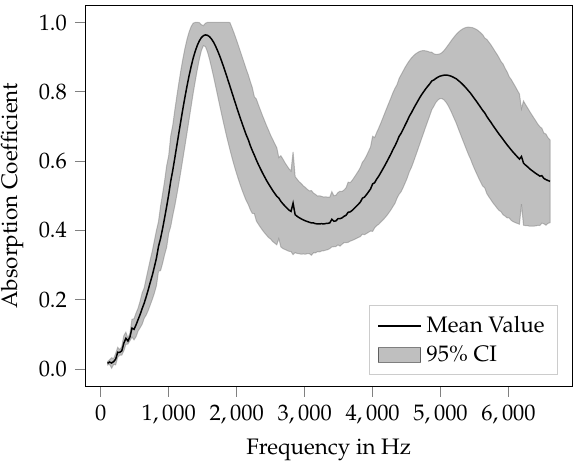
Figure 6. Mean value and confidence interval (CI) for Ref 3 specimen (10% variation of all input